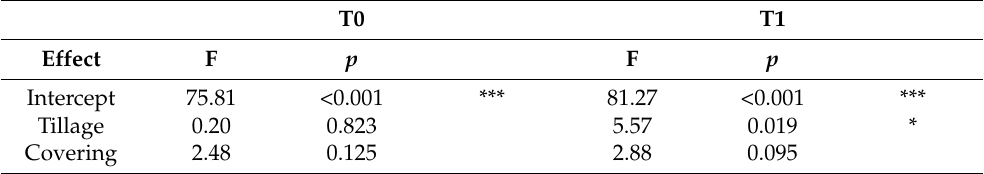
Table 6. Linear mixed model analysis of RSI output.